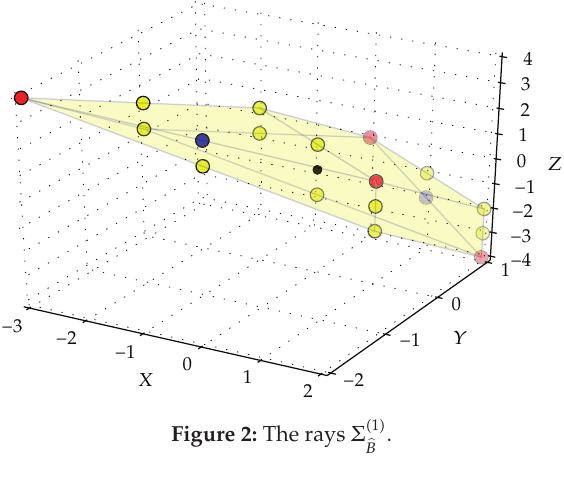
Figure 2: The rays Σ